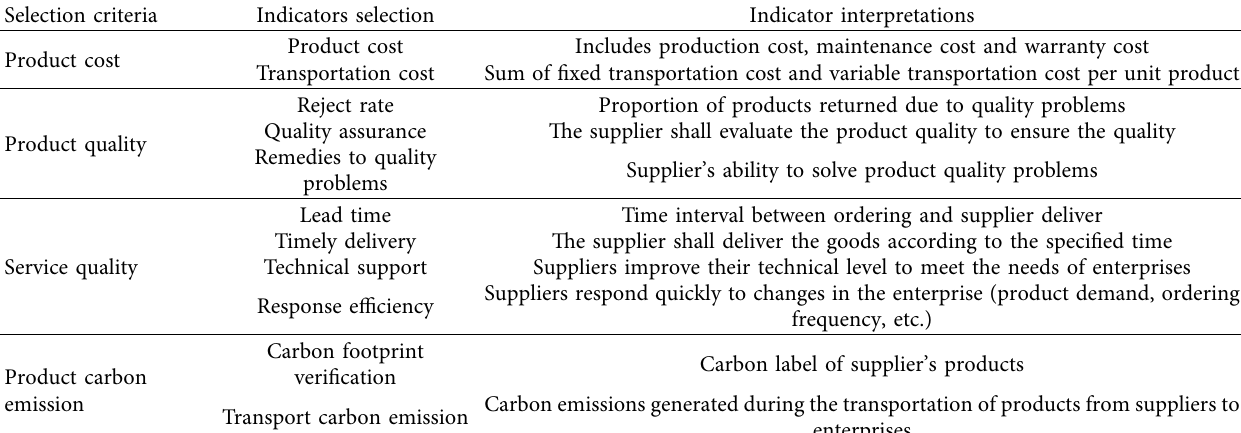
Figure 2: AHP hierarchy of low-carbon supplier selection. Table 1: Indicators selection and